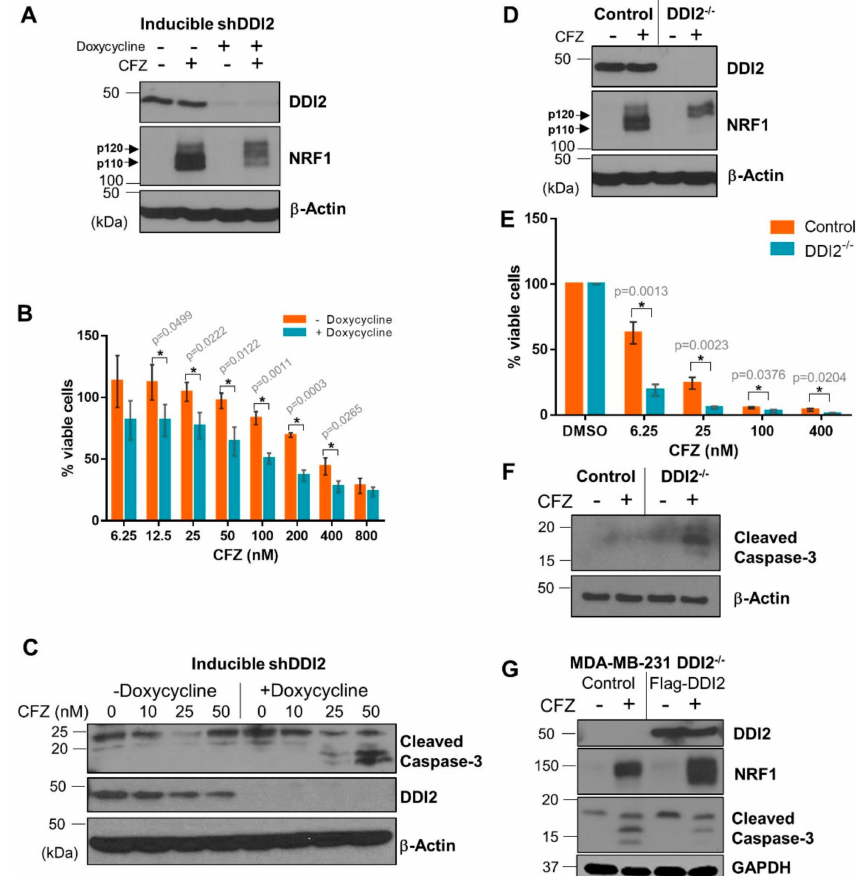
Figure 3. DDI2-deficient MDA-MB-231 cells are more sensitive to carfilzomib-induced cell death. ( A ) MDA-MB-231 cells stably expressing a doxycycline-inducible DDI2 shRNA construct (inducible shDDI2 cells) were incubated with or without doxycycline for ≥ 72 h, then were treated with 200 nM CFZ or equal volume DMSO for 4 h and analyzed by western blot using the antibodies indicated. β -Actin was used as a loading control. Blots shown are representative of three independent experiments. ( B ) MDA-MB-231 inducible shDDI2 cells were treated with or without doxycycline for ≥ 72 h, then were treated with increasing doses of CFZ (6.25–800 nM) for 24 h and analyzed by a luminescent cell viability assay. Viability percentage was determined via comparison to viability of untreated cells (100%). Error bars denote standard deviation ( n = 3). ( C ) MDA-MB-231 inducible shDDI2 cells were treated with or without doxycycline for ≥ 72 h, then were treated with DMSO or 10, 25, or 50 nM CFZ for 24 h and analyzed by western blot using the antibodies indicated. β -Actin was used as a loading control. Blots shown are representative of three independent experiments. ( D ) MDA-MB-231 control (expressing EGFP sgRNA) and DDI2 − / − cells were treated with 200 nM CFZ or equal volume DMSO for 4 h and analyzed by western blots using the indicated antibodies. β -Actin was used as a loading control. Blots shown are representative of three independent experiments. ( E ) MDA-MB-231 control (expressing EGFP sgRNA) and DDI2 − / − cells were treated with DMSO or increasing doses of CFZ (6.25–400 nM) for 24 h and analyzed by MTT assay. Viability percentage was determined via comparison to viability of DMSO-treated cells (100%). Error bars denote standard deviation ( n = 3). ( F ) MDA-MB-231 control (expressing EGFP sgRNA) and DDI2 − / − cells were treated with 10 nM CFZ or equal volume DMSO for 24 h, then the cell lysates were analyzed by western blot with the indicated antibodies. β -Actin was used as a loading control. Blots shown are representative of three independent experiments. ( G ) MDA-MB-231 DDI2 − / − cells expressing a vector control or CRISPR-resistant Flag-WT-DDI2 were treated with 20 nM CFZ or DMSO for 24 h and the cell lysates were subjected to immunoblotting with indicated antibodies. GAPDH was used as a loading control. Blots shown are representative of three independent experiments. Significance ( p value < 0.05) is denoted by